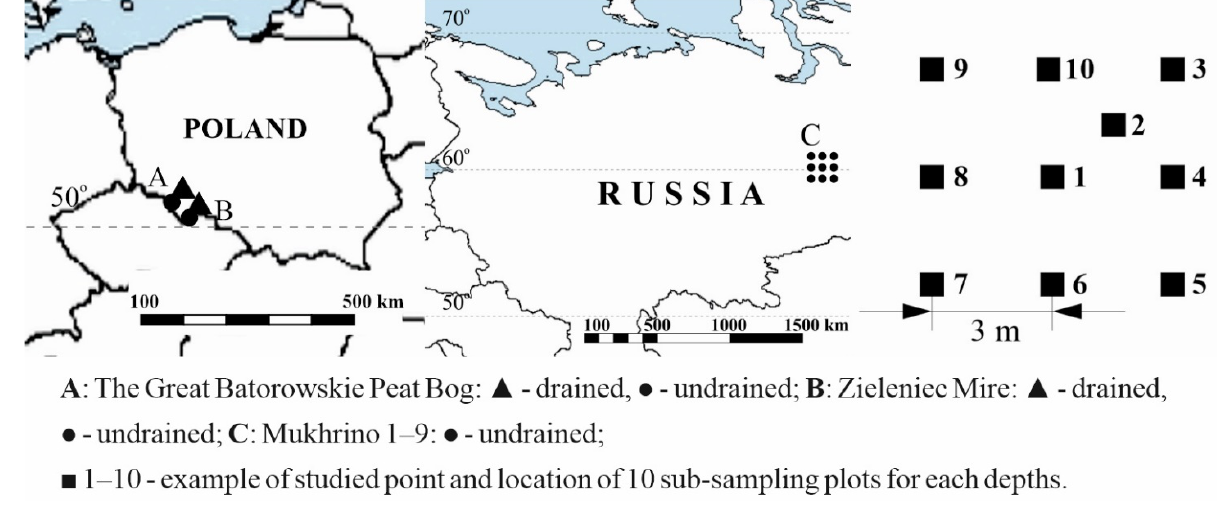
Figure 1. Locations of the 13 sampling points on three different peatlands in Poland and